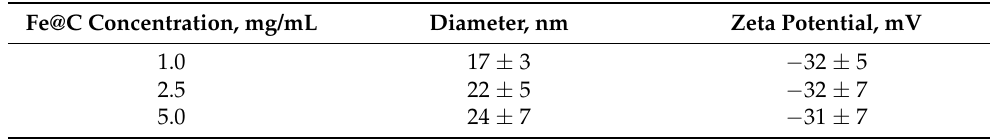
Table 1. Size and Zeta potential of BSA-Fe@C nanoparticles depending on Fe@C